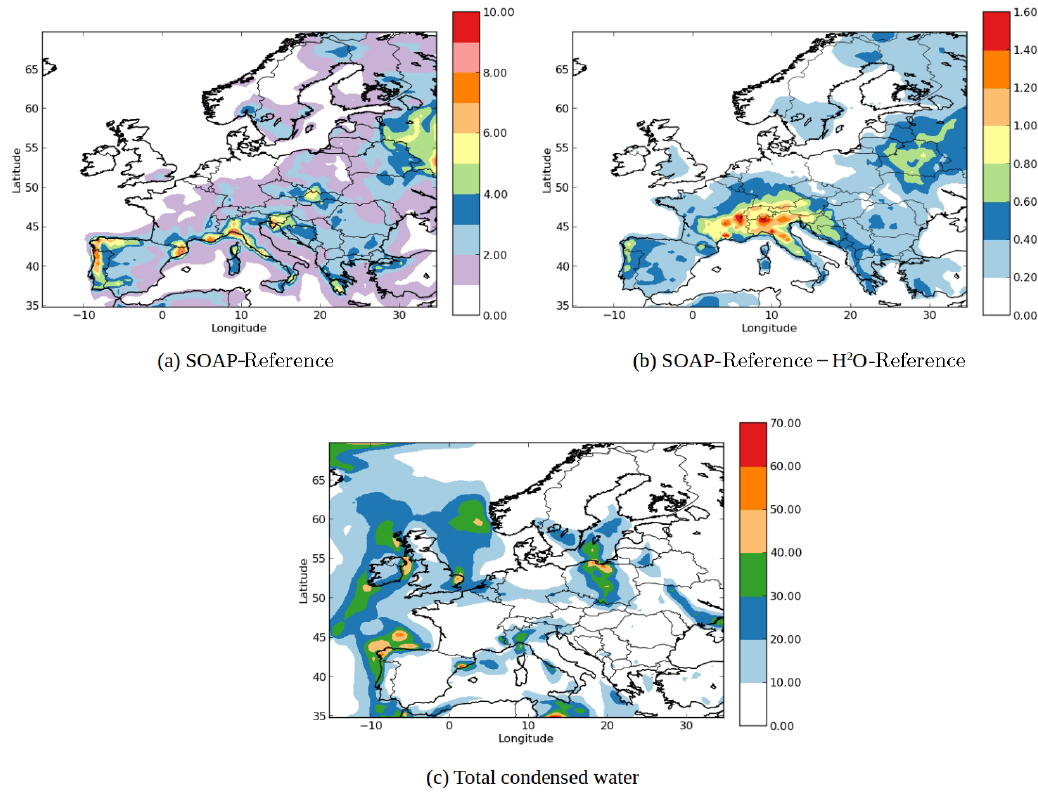
Figure 4. (a) SOA concentrations in the SOAP-Reference simulation (µgm − 3 ), (b) the differences of the SOA concentrations between the SOAP-Reference and H 2 O-Reference simulations (µgm − 3 ) and (c) concentration of total condensed water in the SOAP-Reference simulation (µgm − 3